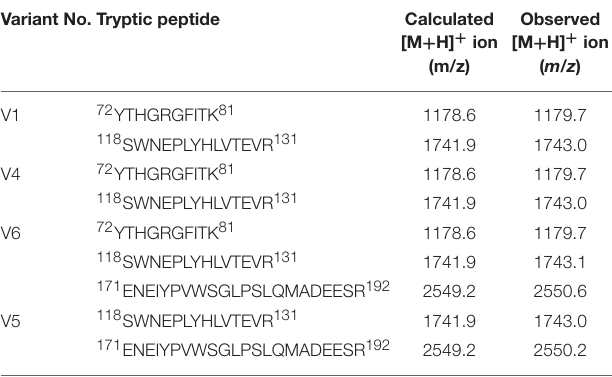
FIGURE 5 | 2DGE-based Western blot confirmed hPRL variants in pituitary tissues. IEF was done with an 18-cm IPG strip (pH 3-10, nonlinear), and vertical SDS-PAGE was done with a 12% polyacrylamide gel. The primary antibody was rabbit anti-hPRL antibody. The second antibody was goat anti-rabbit alkaline phosphtase-conjugated IgG. (A) Western blot image of anti-hPRL proteins (rabbit anti-hPRL antibodies + goat anti-rabbit alkaline phosphtase-conjugated IgG). (B) Silver-stained image on a 2D gel after transfer of protein to a PVDF membrane.